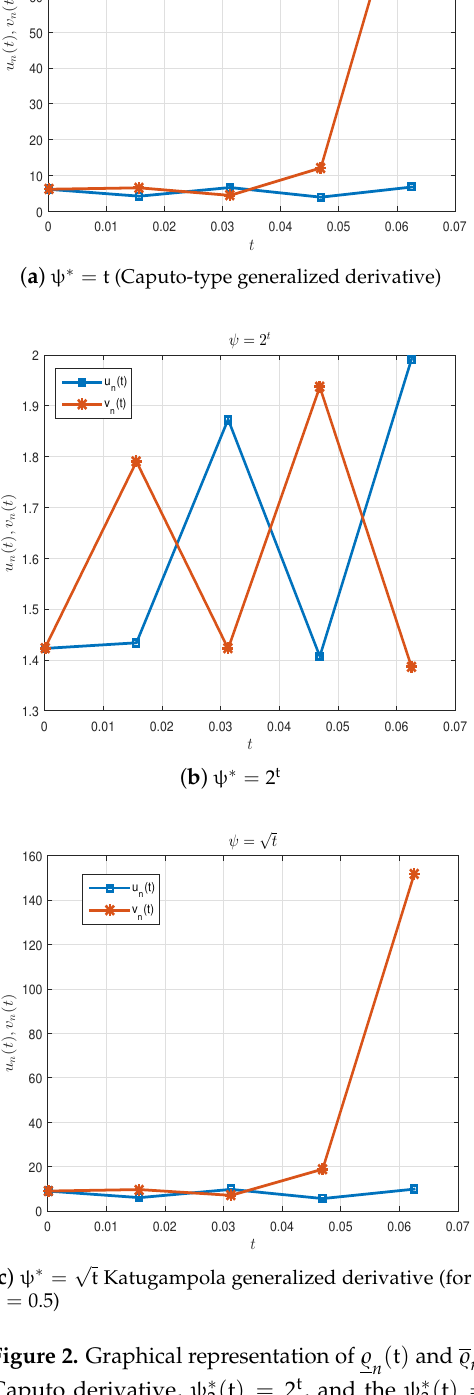
( t ) = 2 t , and the ψ ∗ 2